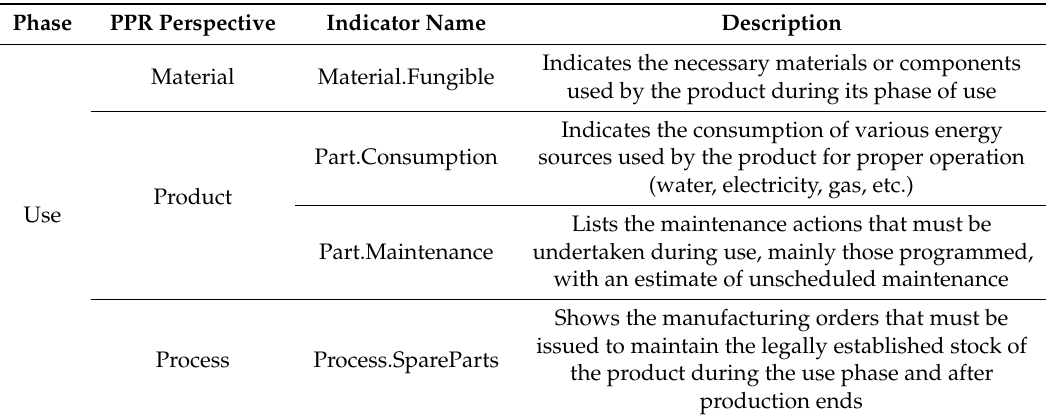
Table 6. Use phase indicators